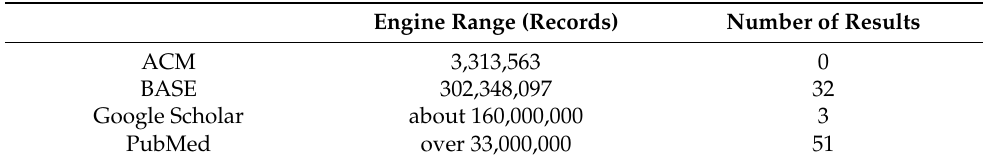
Table 4. Engine ranges and number of results on final searches.